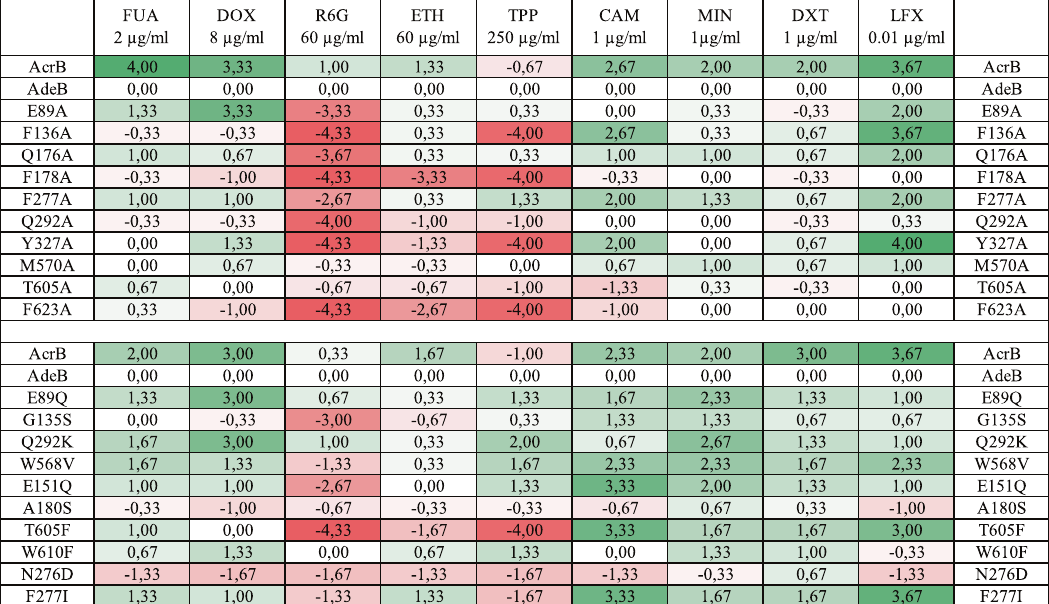
Fig. 6 Drug susceptibility pro fi les of E. coli harboring AdeB deep-binding pocket variants. Analysis of plate dilution assays with E. coli AcrB, wildtype A . baumannii AdeB, inactive AcrB variant (D407N) and AdeB deep-binding pocket (DBP) variants (E89A, F136A, Q176A, F178A, F277A, Q292A, Y327A, M570A, T605A, F623A, E89Q, G135S, Q292K, W568V, E151Q, A180S, T605F, W610F, N276D, F277I). Plate dilution assays were performed with E. coli BW25113 Δ acrB Δ acrD Δ mdtBC pRSFDuetFX_MS_ adeAC harboring pET24_ acrB or p7XC3H_ adeB _WT and mutants. Dilution series of overnight